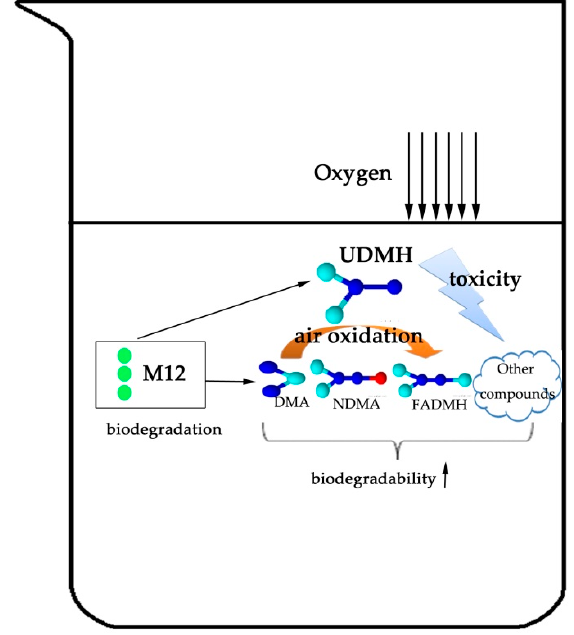
Figure 9. The influence of air oxidation on UDMH degradation for M12 strain in solution.